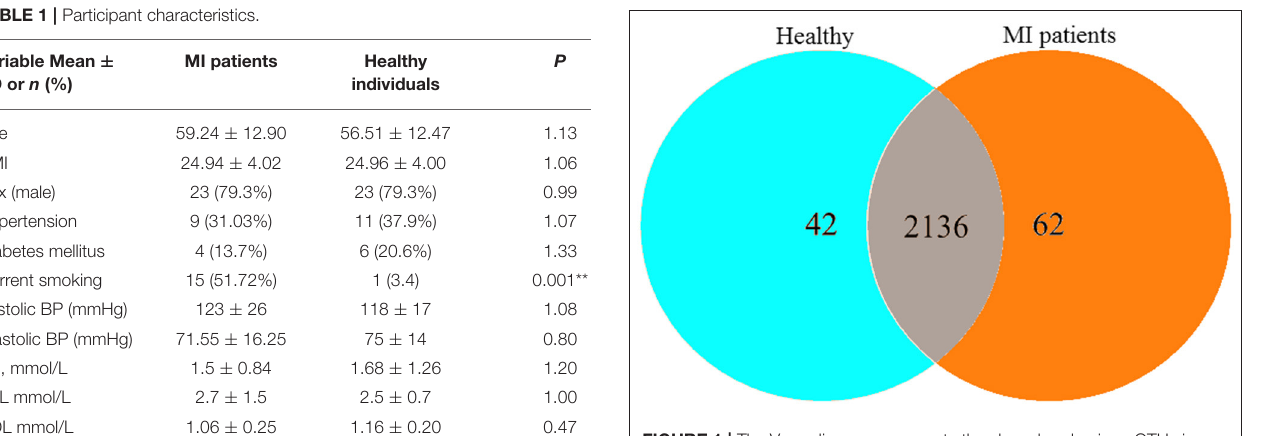
FIGURE 1 | The Venn diagram represents the shared and unique OTUs in both MI and HC groups.